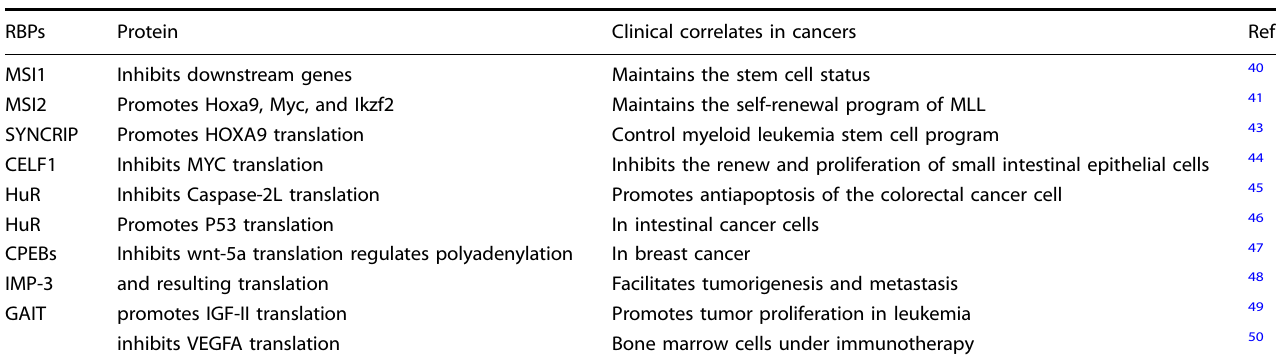
Table 1. RNA-binding proteins involved in translation